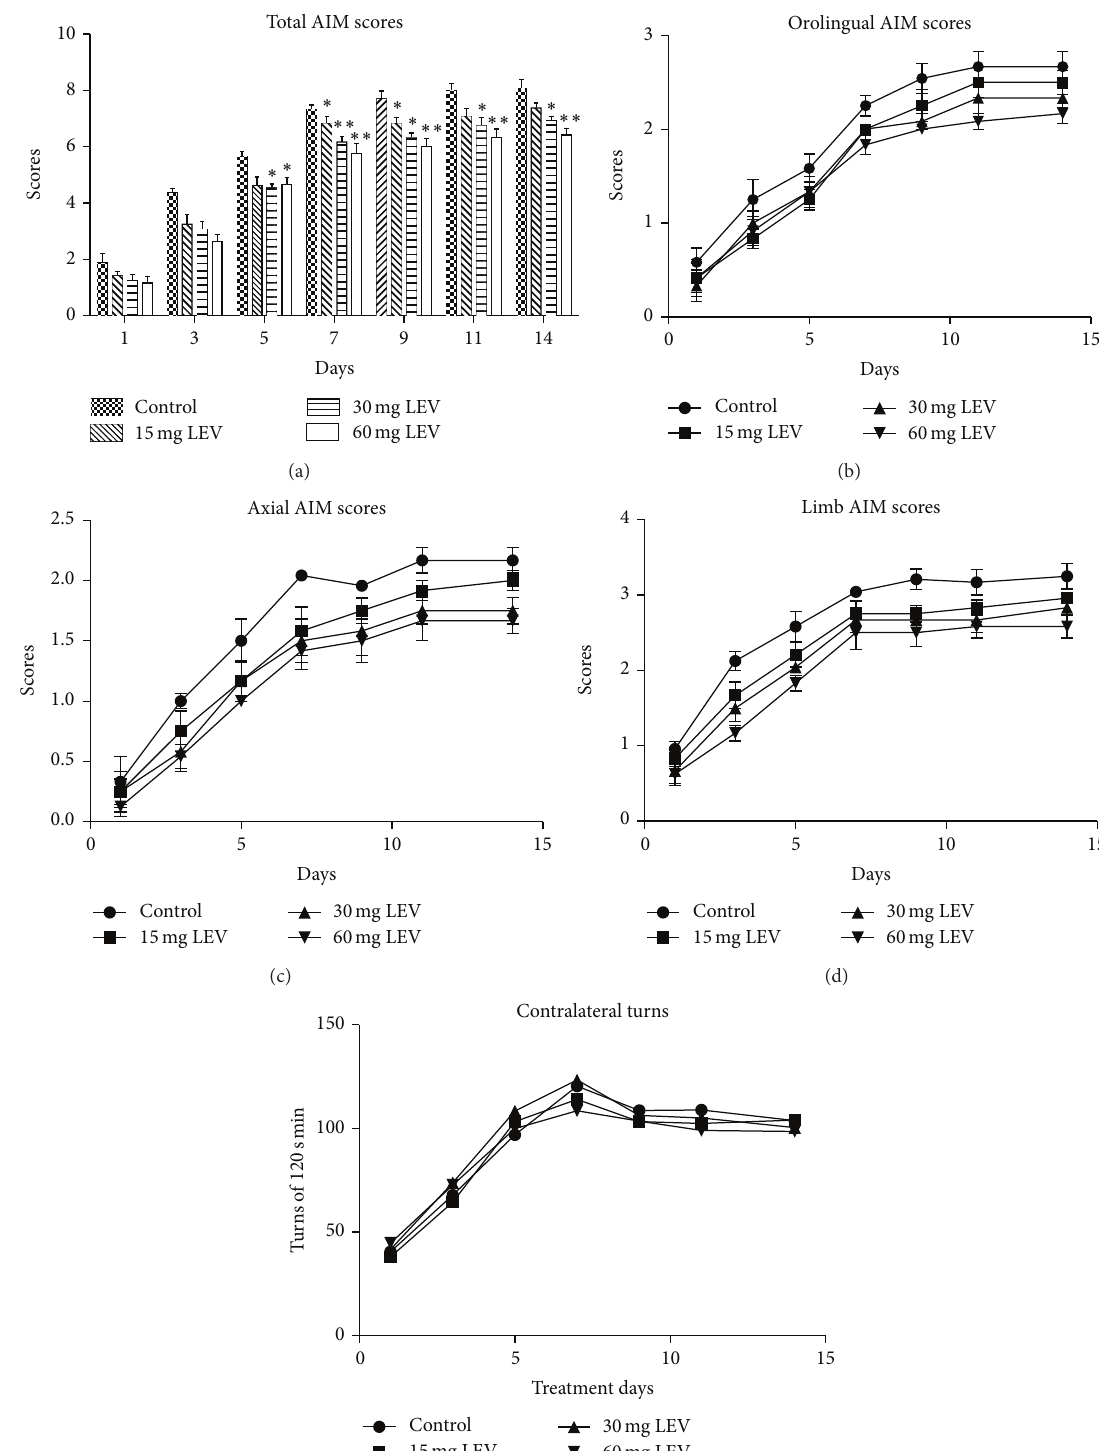
Figure 1: Effects of levetiracetam on abnormal involuntary movements (AIMs) induced by L-DOPA in hemiparkinsonian rats. Animals were assessed on days 1, 3, 5, 7, 9, 11, and 14 following L-DOPA methyl ester (12mg/kg) plus benserazide-HCl (3mg/kg) (i.p.). Two hours prior to each L-DOPA injection, animals received levetiracetam 0 (control group, vehicle injection), 15, 30, or 60mg/kg by gavage. Total AIMs scores (a) include orofacial (b), axial (c), and limb (d) AIMs scores. Rotational behavior (contralateral turns, (e)) shows that levetiracetam induced no changes in the antiparkinsonian action of L-Dopa. Values are mean ± SEM. ∗ 𝑃 < 0.05 and ∗∗ 𝑃 < 0.01 versus control group ( 𝑛 = 10 per group; LEV: